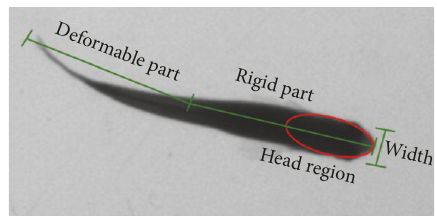
Figure 5: Fish tracking by detecting fish head region [23].